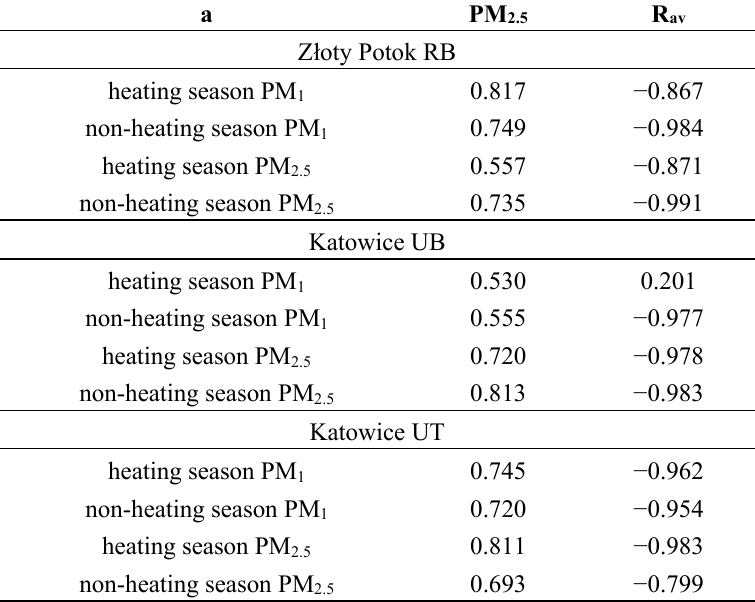
Table 4. Values of the linear correlation coefficient (R, p < 0.05) for the 24-h light absorption coefficient (a) values, light reflection coefficient R av values, and 24-h PM